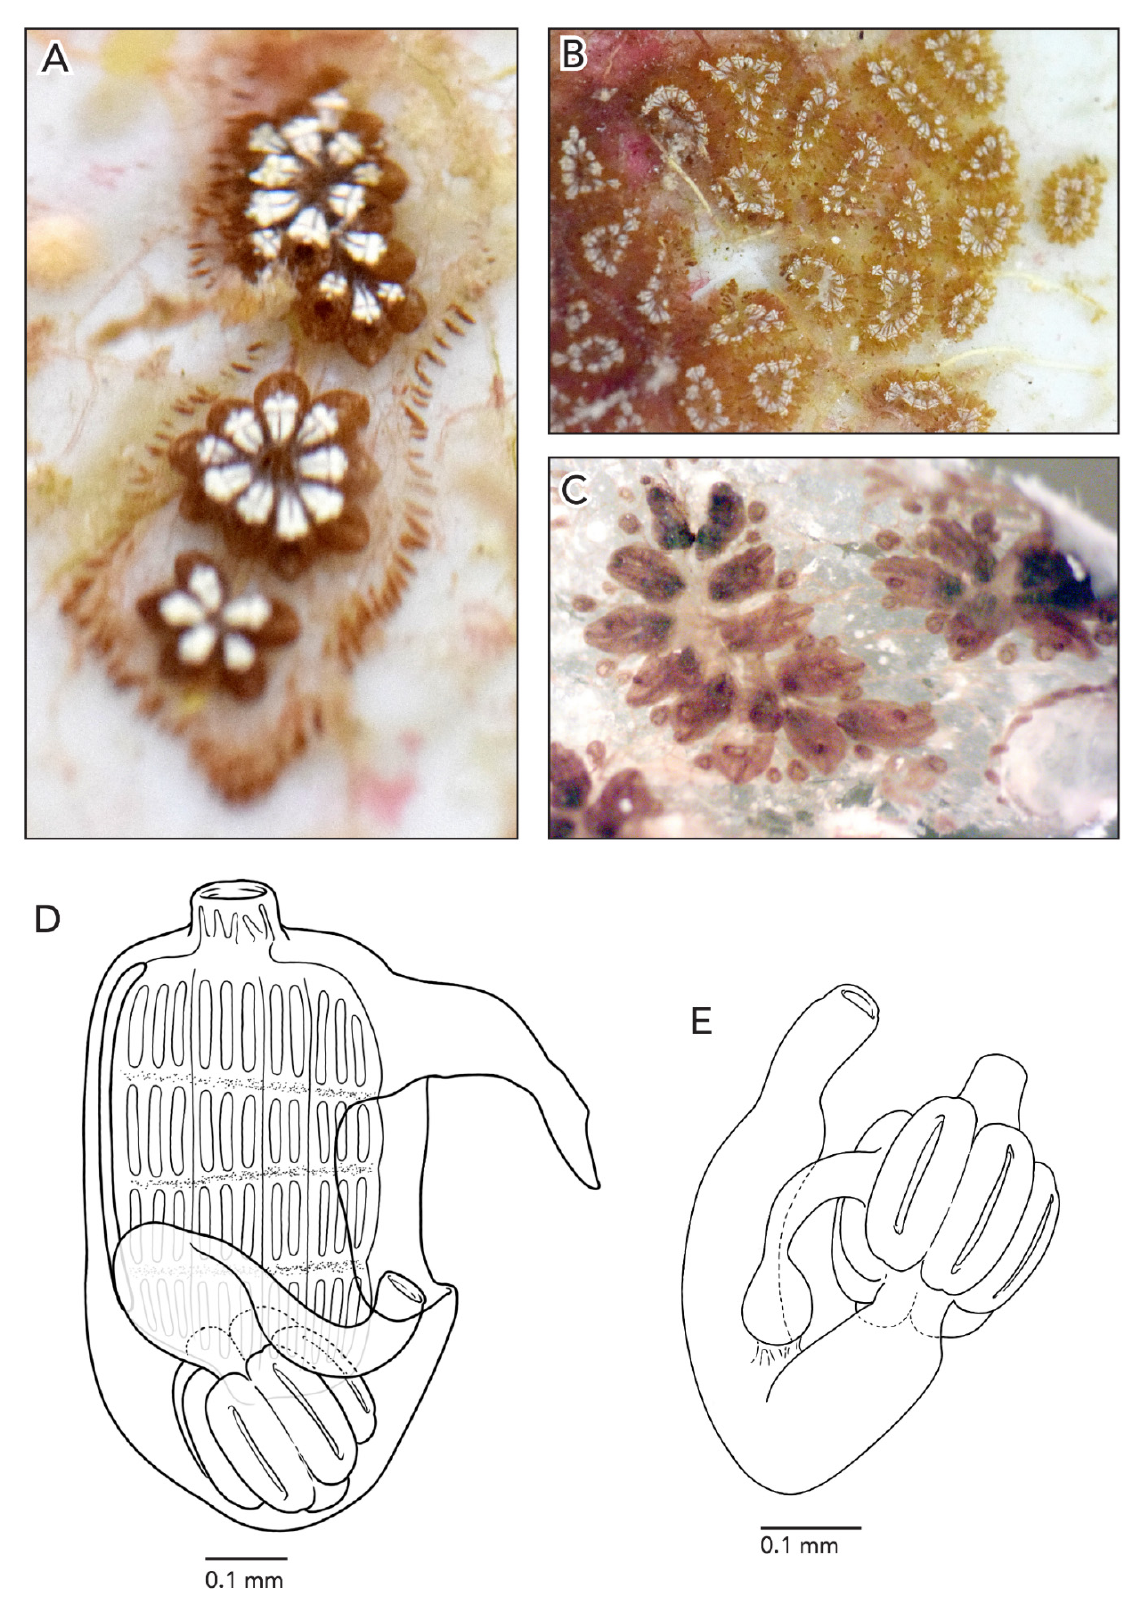
Figure 7. Botryllus lambertorum sp. nov. ( A , B ) Live colonies on artificial substrate (PVC) ( C ) Detail of the systems in a preserved colony ( D ) Left side view of a zooid ( E ) Detail of the abdomen region.